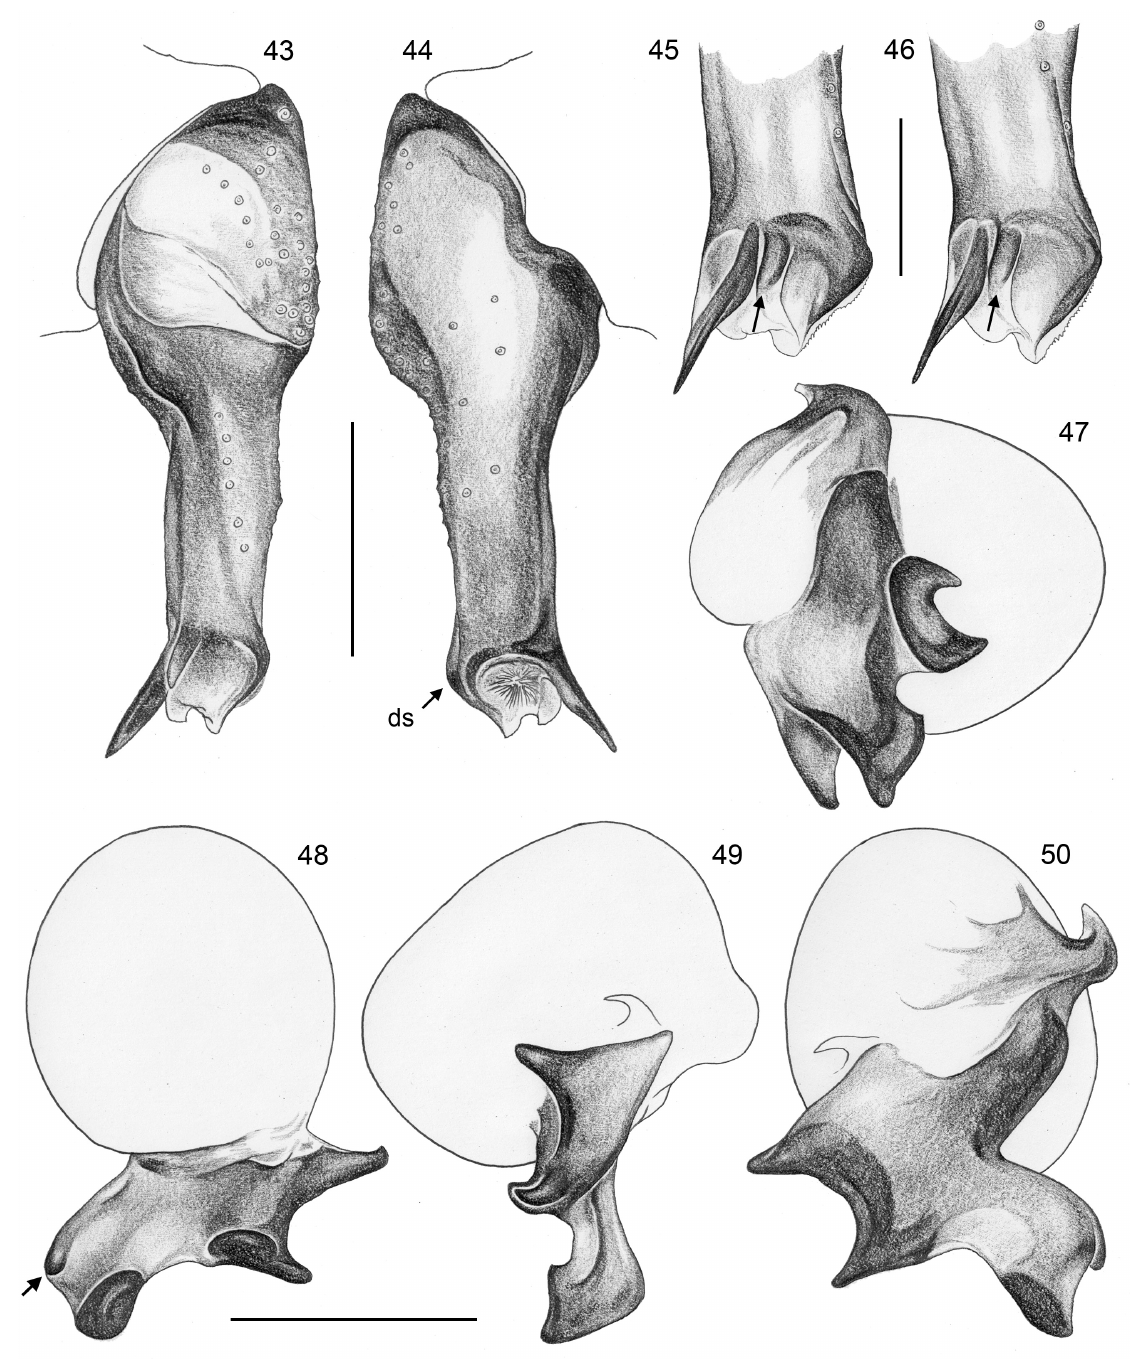
Figs 43–50. Stygopholcus skotophilus Kratochvíl, 1940. 43–44 . Male from Ilijina pećina, Bosnia and Herzegovina (ZFMK (Ar 22198)), left tarsus and procursus, prolateral and retrolateral views. 45– 46 . Males from Pećina u Ivici, Montenegro (ZFMK (Ar 22196)) and from Grabova pećina, Sedlari, Bosnia and Herzegovina (MHNG), tip of left procursus, prolateral (slightly ventral) views; arrows point at distinctive prolateral sclerites. 47–50 . Male from Ilijina pećina (ZFMK (Ar 22198)), left genital bulb, retrolateral, ventral, prolateral-distal, and dorso-distal views; arrow points at wart that is more strongly developed in specimens from near Sedlari. ds = dorsal sclerite. Scale bars: 43–44, 47–50 = 0.5 mm; 45–46 = 0.25